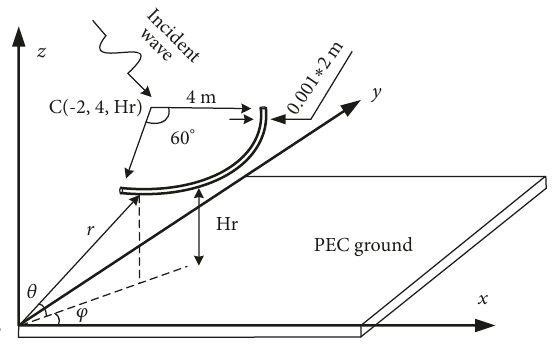
Figure 5: Curved conductor above flat ground. Conductor’s length is 4.19 m.